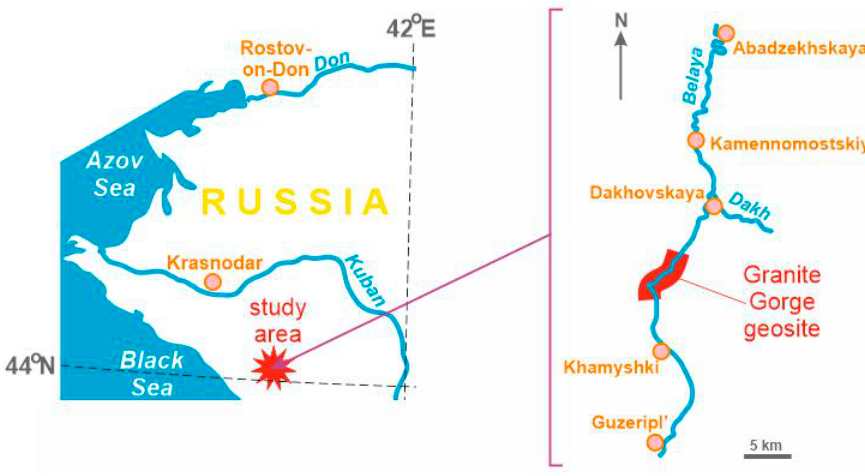
Figure 1. Location of the study geosite.